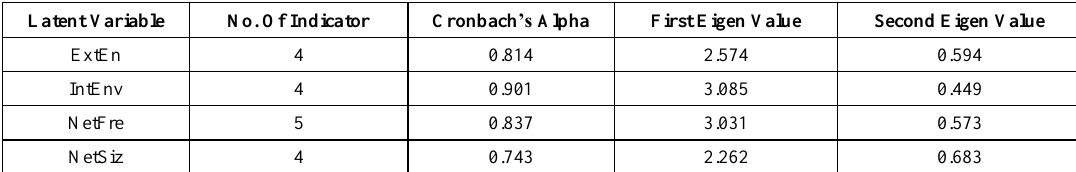
Table 1. Uni- dimensionality